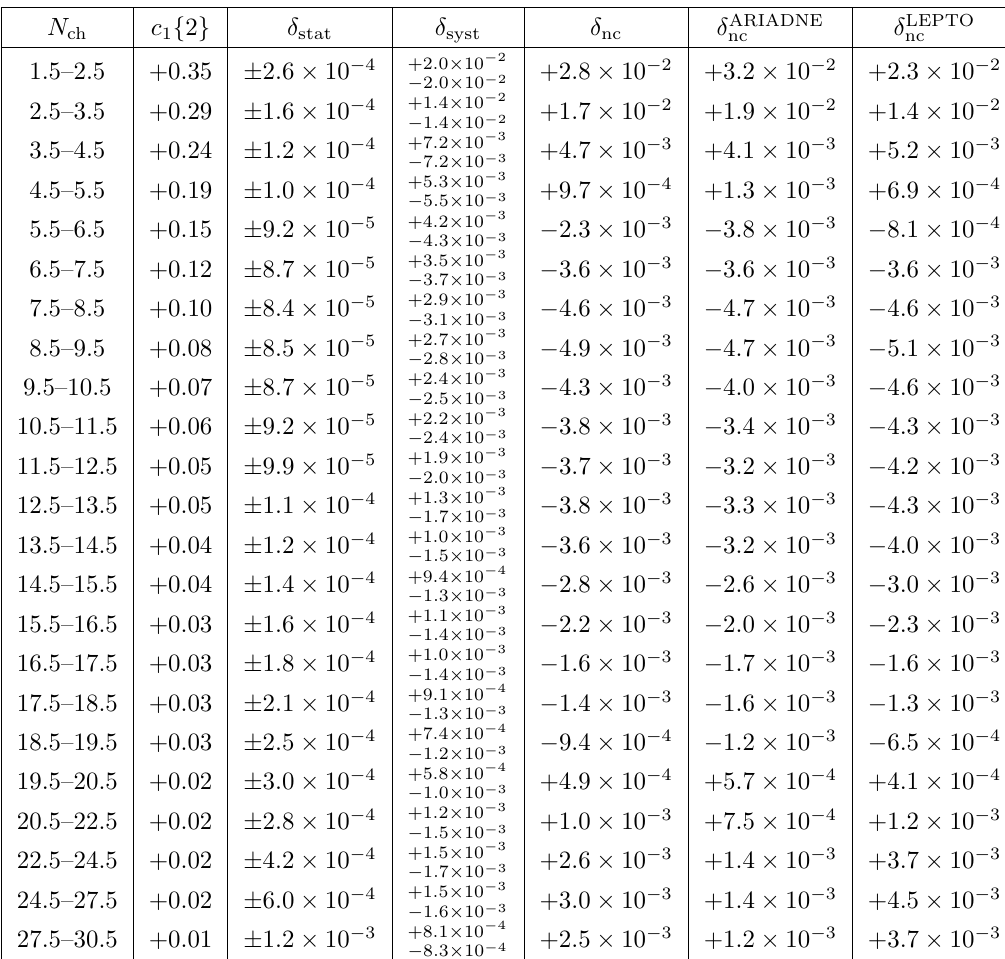
Table 1 . c 1 f 2 g versus N ch from (cid:12)gure 7 (a) and (cid:12)gure 10 (a), p T > 0 : 1 GeV, no j (cid:1) (cid:17) j cut; (cid:14) stat , (cid:14) syst and (cid:14) nc denote the statistical, systematic and Monte Carlo non-closure uncertainties, respectively.